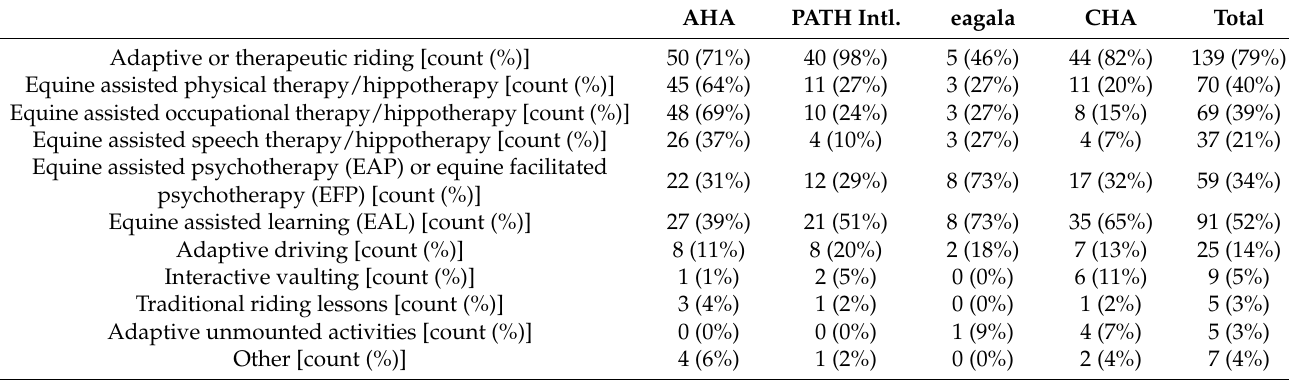
Table 5. Types of programming offered by AHA, PATH Intl., eagala, and CHA centers. AHA PATH Intl. eagala CHA Total